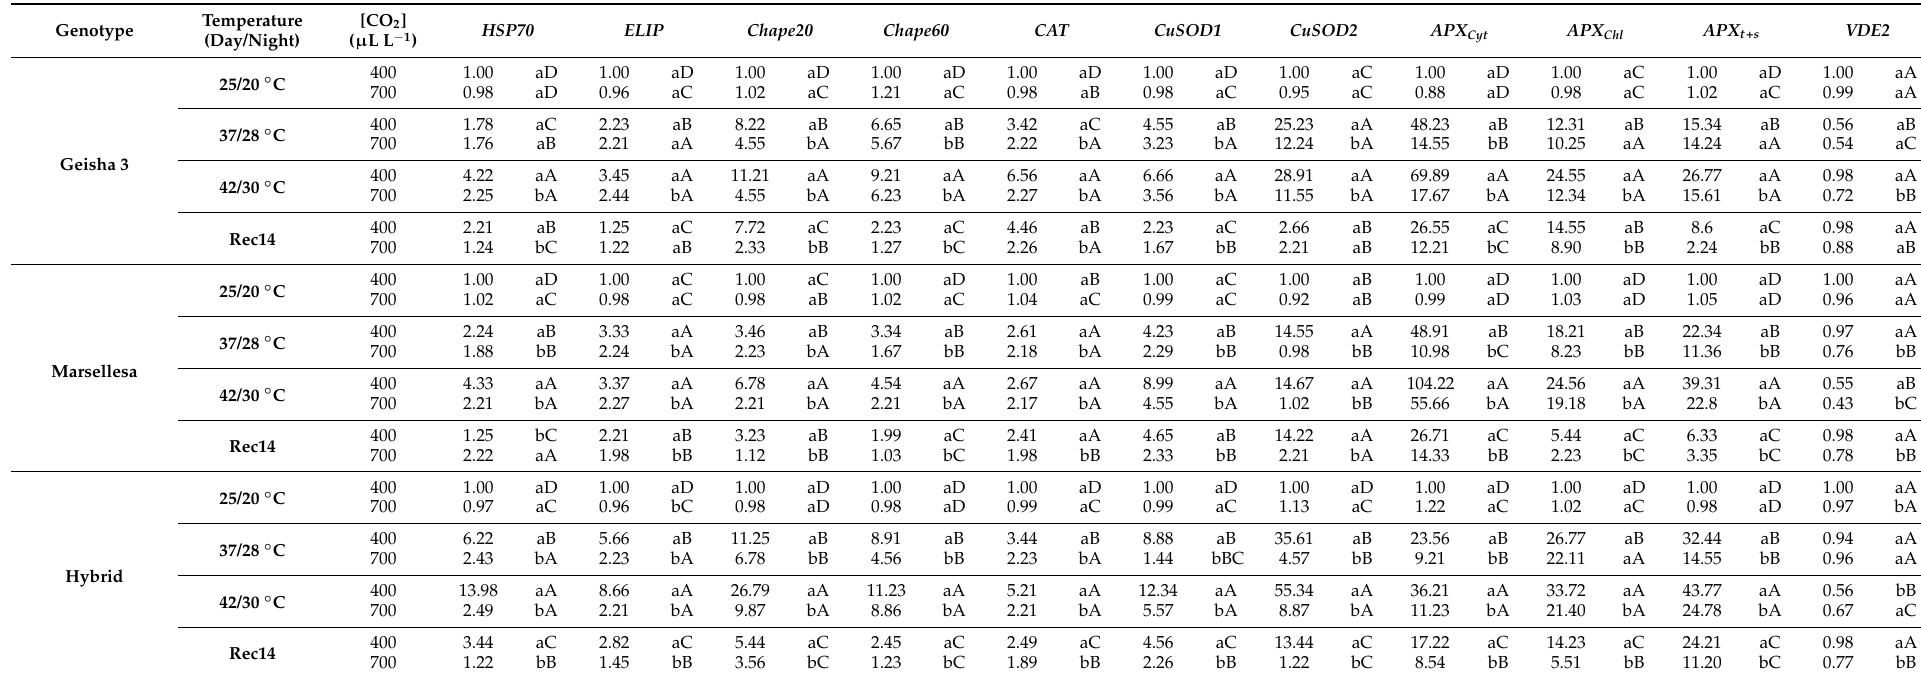
Table 2. Real-time PCR expression studies relative to the expression value observed under control conditions of temperature and CO 2 (25/20 ◦ C, 400 µ L CO 2 L − 1 ) from leaves of C. arabica cv. Geisha3, cv. Marsellesa and their Hybrid (Geisha 3 × Marsellesa) plants grown under 400 or 700 µ L CO 2 L − 1 at control (25/20 ◦